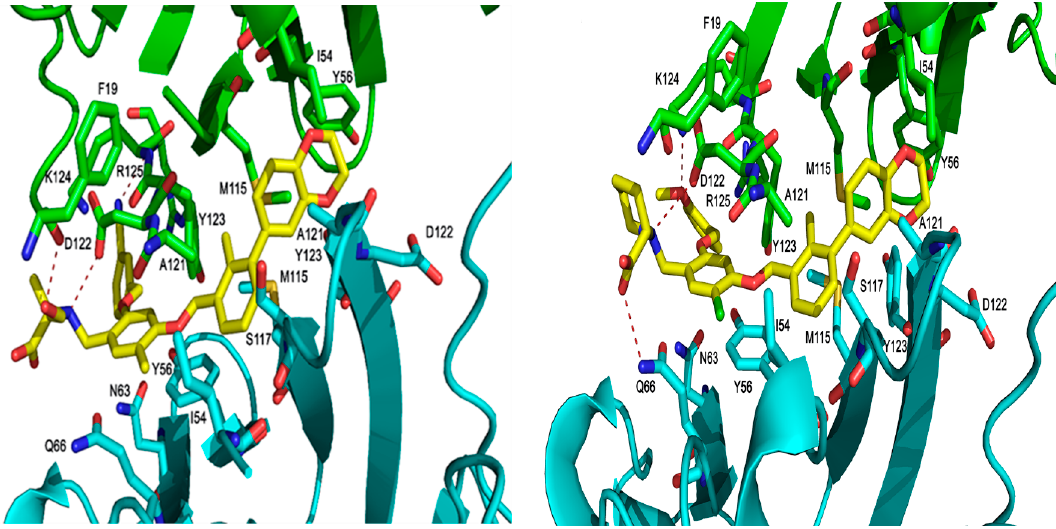
Figure 7. The binding orientation of compound 1 (left), and compound 3 (right) in the PD-L1 protein of 5NIU. The H-bond is depicted with a dark dotted line. Chain D is colored with a green secondary structure and atoms, whereas Chain C is in cyan